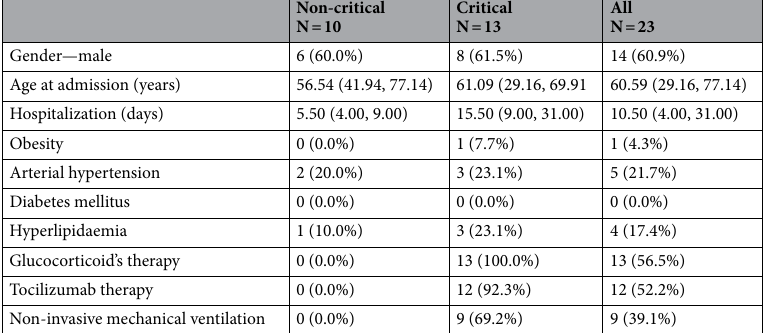
Table 1. Demographic and clinical parameters of patients included in the study. Frequencies and percentages are used to summarize categorical variables, while median and the range (minimum and maximum values) are used for continuous variables.